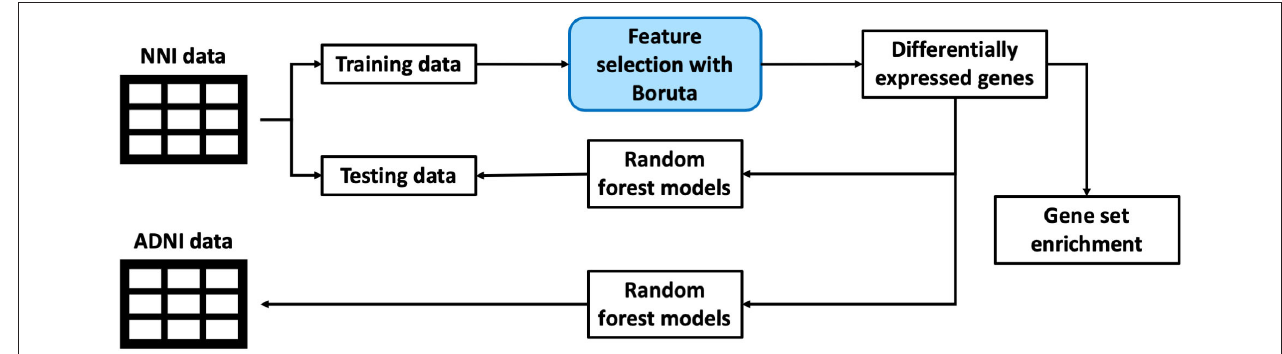
FIGURE 1 | An illustration of the overall framework for studying biomarkers from blood gene expression.